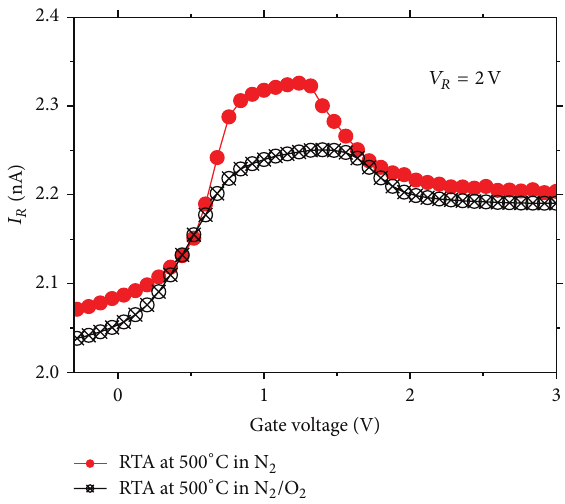
Figure 2: Reverse diode current 𝐼 𝑅 of the HfO 2 gated diode versus gate voltage 𝑉 𝐺 at 𝑉 𝑅 = 2 V. 𝑉 𝑅 is the reverse bias of the 𝑁 + region of the metallurgical junction.